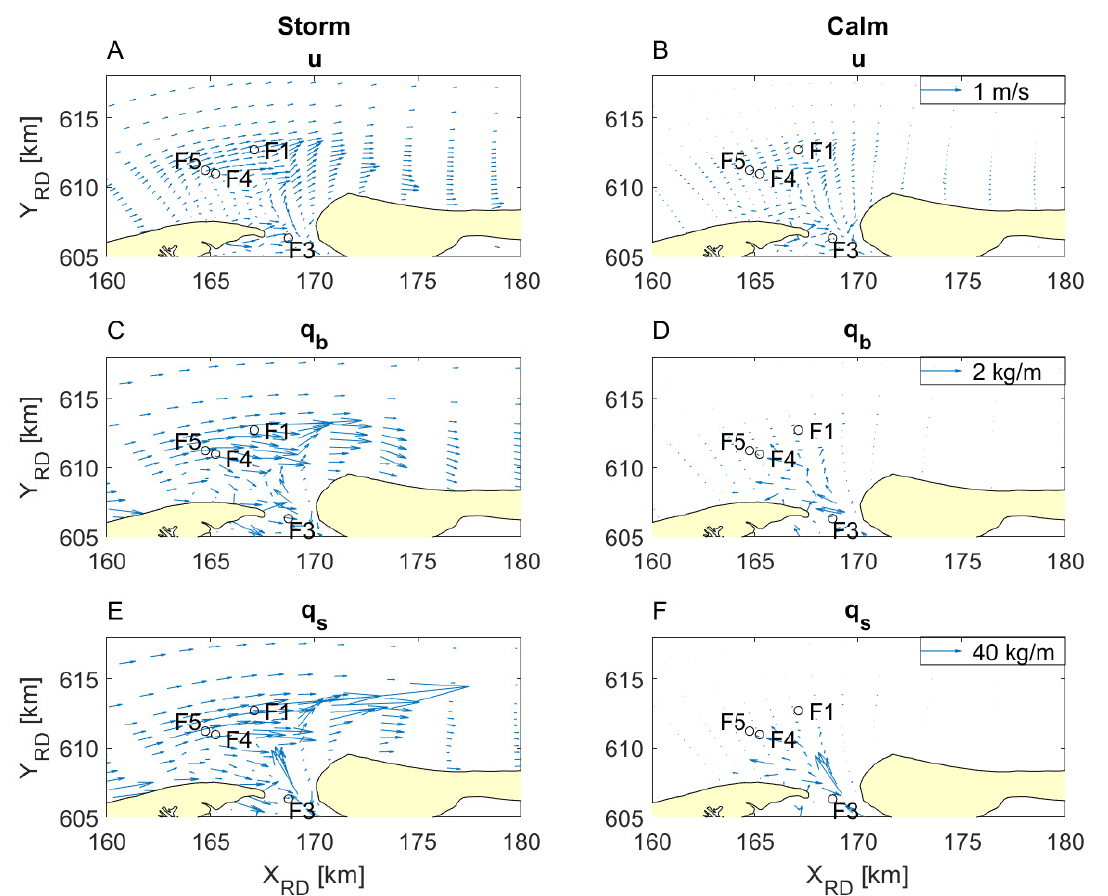
Figure 7. Time-averaged value of depth-averaged current velocity magnitude ( A , B ), time-integrated bedload transport ( C , D ) and time-integrated suspended load transport ( E , F ) during the storm ( A , C , E ) and the calm weather period ( B , D , F ) on a select number of model grid